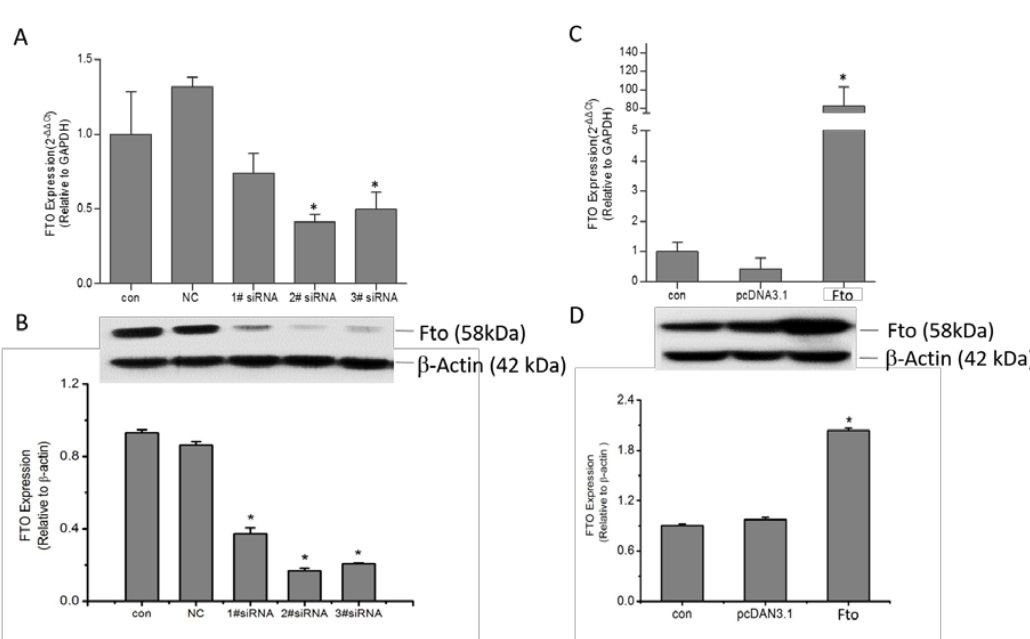
Figure 1. Construction of Fto knockdown or overexpressed pre-adipocyte model: ( A ) 3T3-L1 cells were transfected with siRNA control or three Fto specific siRNAs for 24 h. Fto mRNA was identified using qRT-PCR, with GAPDH as control gene. The value of 2 −∆∆ CT was represented as Means ± SD of three independent analyses. * p < 0.05, versus NC group. ( B ) Western blot was applied to determine the Fto protein expression. The expression level was quantified as fold changes in grey value, with β -actin as the loading control. * p < 0.05, versus NC group. ( C ) The Fto mRNA expression and ( D ) protein expression level in 3T3-L1 cells were separately detected 24 h after transient transfection of pcDNA3.1-Fto or empty pcDNA3.1 vector, as described above. * p < 0.05 versus empty pcDNA3.1 vector group.